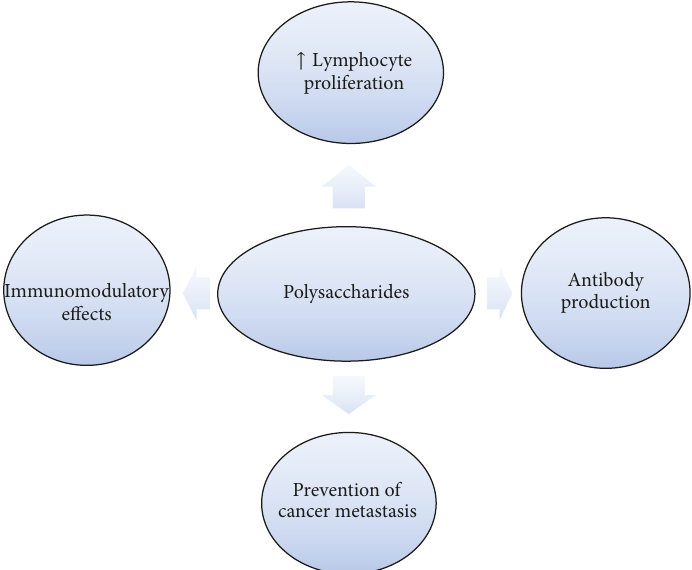
Figure 6: Antitumor properties of polysaccharide